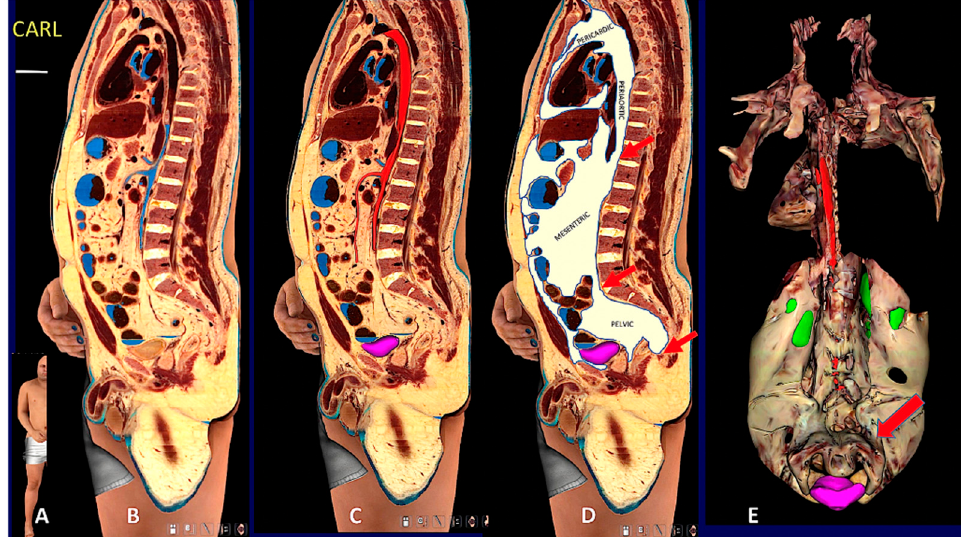
Figure 6. Digital cadaver section and 3D reconstruction showing upper and lower subcutaneous visceral continuity in the Adipose Organ. ( A ): Sagittal oblique section of the digital cadaver, Carl. ( B – D ): Mediastinal ‐ abdomino ‐ pelvic and gluteal subcutaneous ‐ visceral connection (SVC). ( B ): orig ‐ inal section, ( C ): aorta and upper mesenteric artery in red, ( D ): fat highlighted in white. Arrows in ( D ) point to mediastinic ‐ abdominal (upper), abdomino ‐ pelvic (middle) and gluteal ‐ pelvic (lower) connections. Gluteal ‐ pelvic SVC is also shown in Supplementary Figure S16. Panel ( E ) shows a 3D reconstruction of the whole visceral fat. Dorsal view in which the continuity between retroperitoneal and pelvic fat surrounding the urinary bladder is more evident, indicated by the arrow. Green: kid ‐ neys (parts of dorsal surface not covered by retroperitoneal fat), violet: urinary bladder. Arrows point to periaortic fat in the mediastinic ‐ abdominal connection. See also Suppl movie. Bar: in ( B – D ) 60 mm, in ( E ) 120 mm.